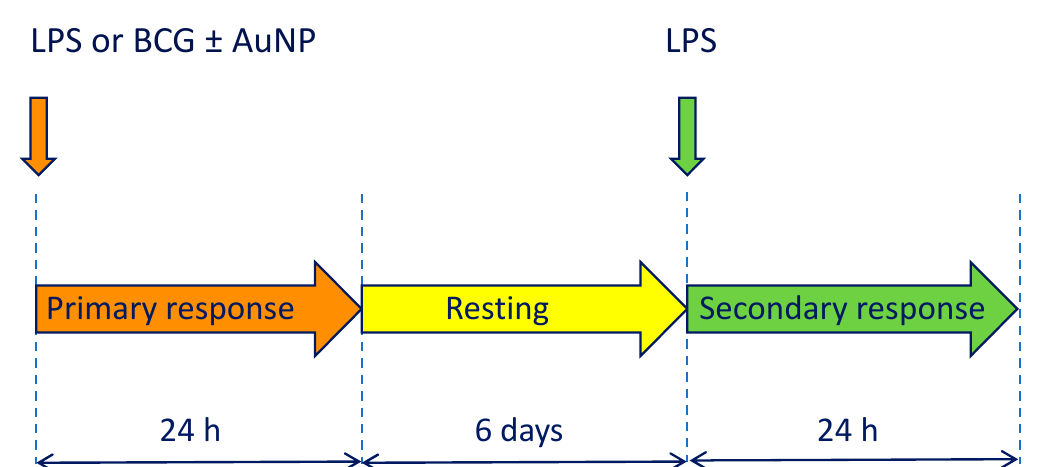
Figure 2. Schematic depiction of the in vitro model of innate immune memory. Primary activation was induced by stimulation for 24 h with LPS or BCG, in the absence or in the presence of AuNP. Supernatants were collected and cells rested for six days. On day 7, a secondary response was induced by challenge with LPS for 24 h (control groups were challenged with medium alone), after which supernatants were collected for evaluation of cytokine production.